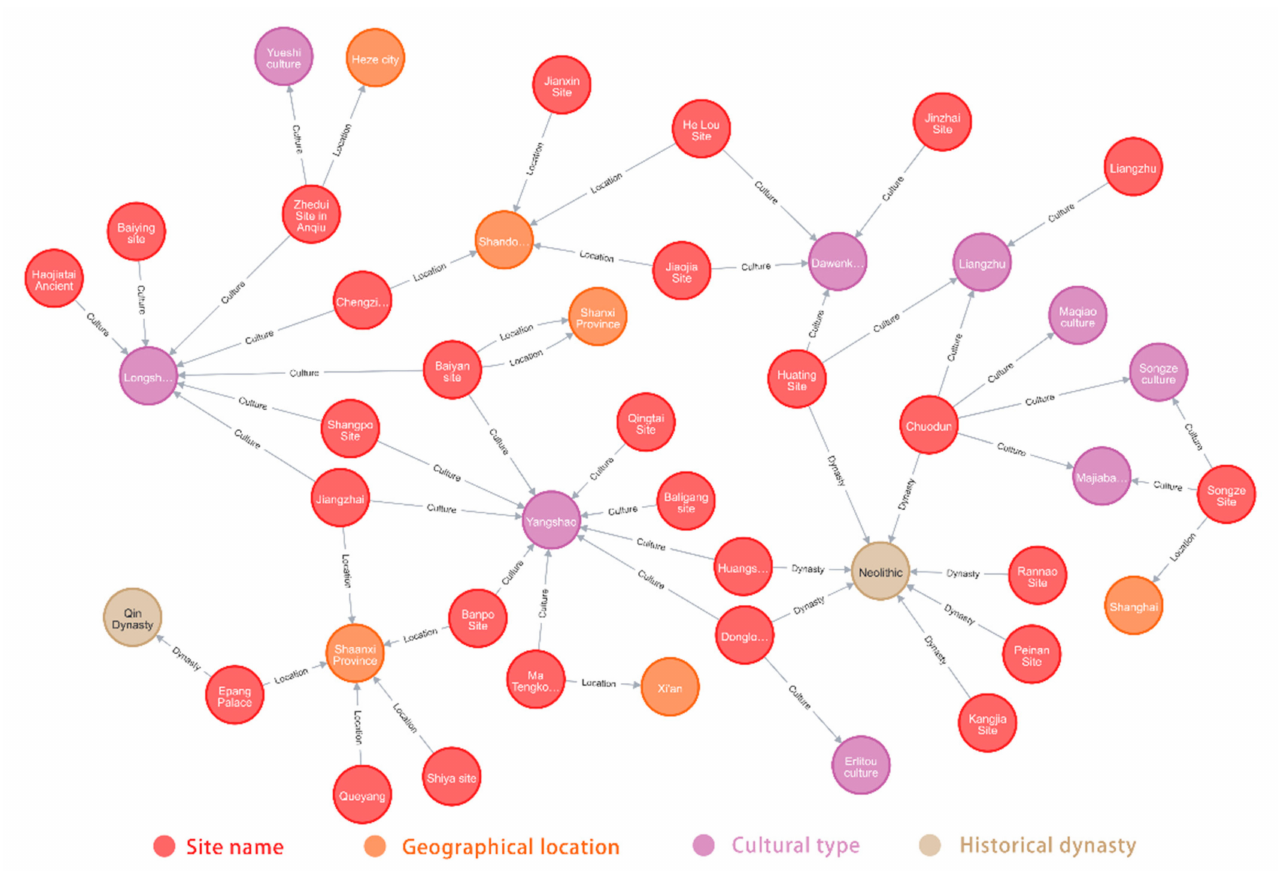
Figure 5. Instance of archaeological site knowledge graph